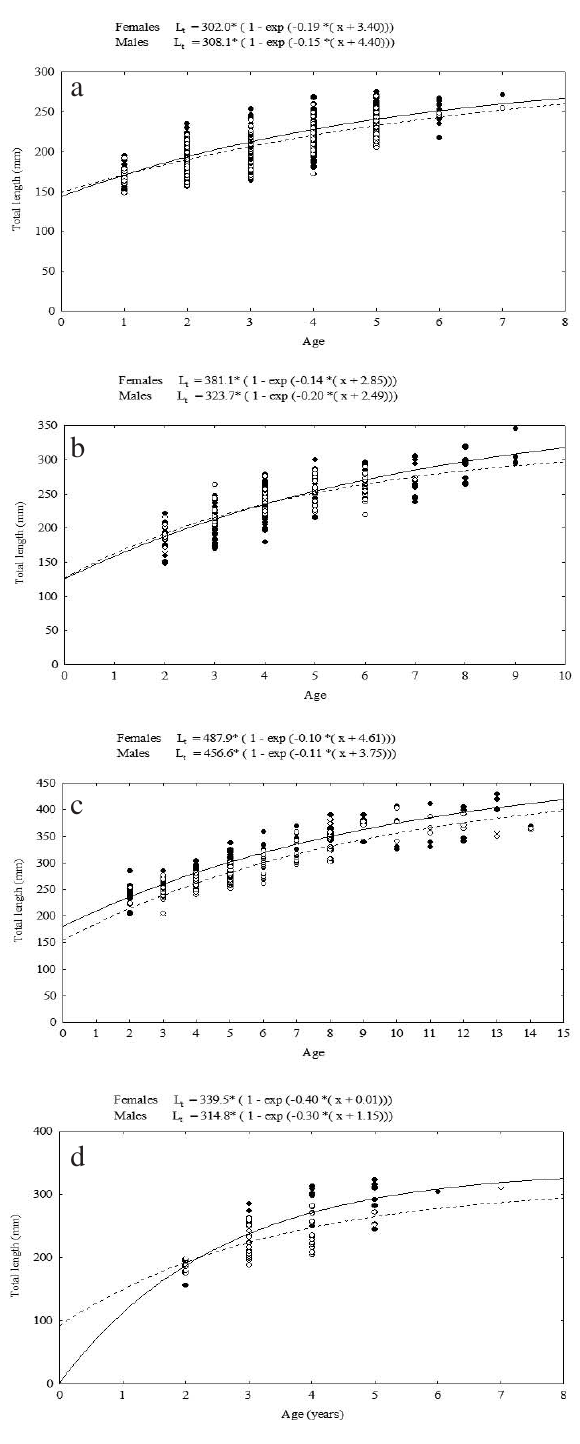
Fig . 2. – von Bertalanffy growth curves fitted to length-at-age data of C. linguatula (a), L. boscii (b), P. flesus (c), and M. azevia (d) (females, black circles and solid lines; males, empty circles and dashed lines).